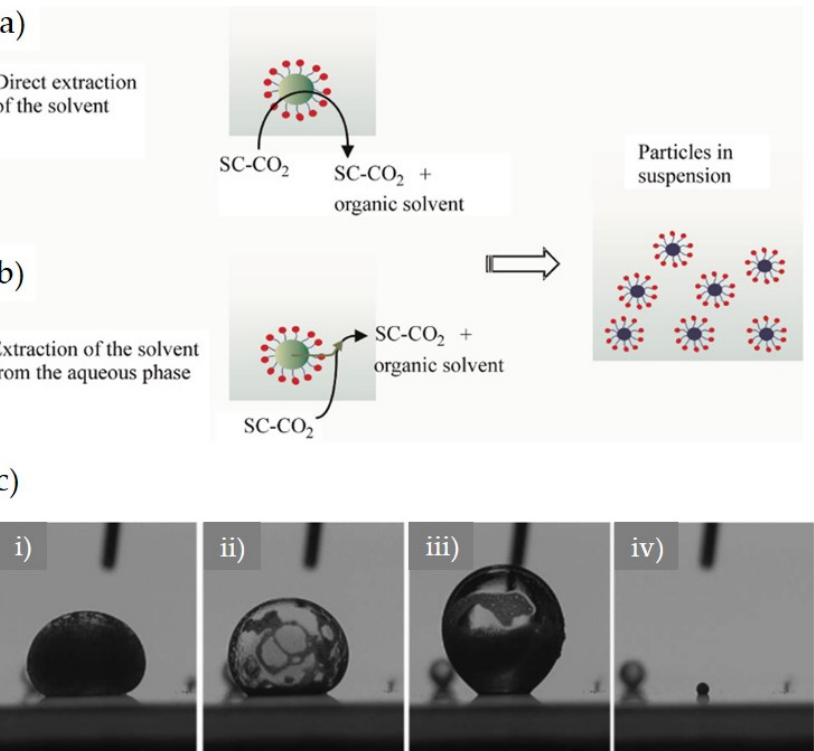
Figure 6. Schematic representation of the possible mass transfer pathways of the oily phase during the SFEE process. Two parallel pathways: ( a ) direct supercritical extraction upon contact between SC-CO 2 and the organic phase into the droplet; ( b ) diffusion of the organic solvent into water followed by subsequent supercritical extraction of the solvent from the aqueous phase; and ( c ) change behavior of the volume and appearance of the organic solvent droplet as an oil phase suspended in aqueous phases overtime during the extraction process at the supercritical state: ( i ) beginning of particle formation with swelling, ( ii and iii ) continuous swelling and particle precipitation, and ( iv ) final condition after shrinking. Reprinted from [44] (Elsevier 2011) and [53] (Wiley 2009) with permission.